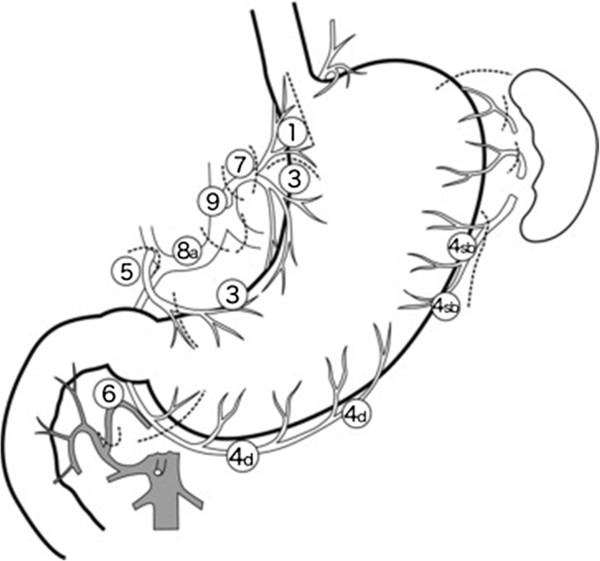
Lymph node station[1].